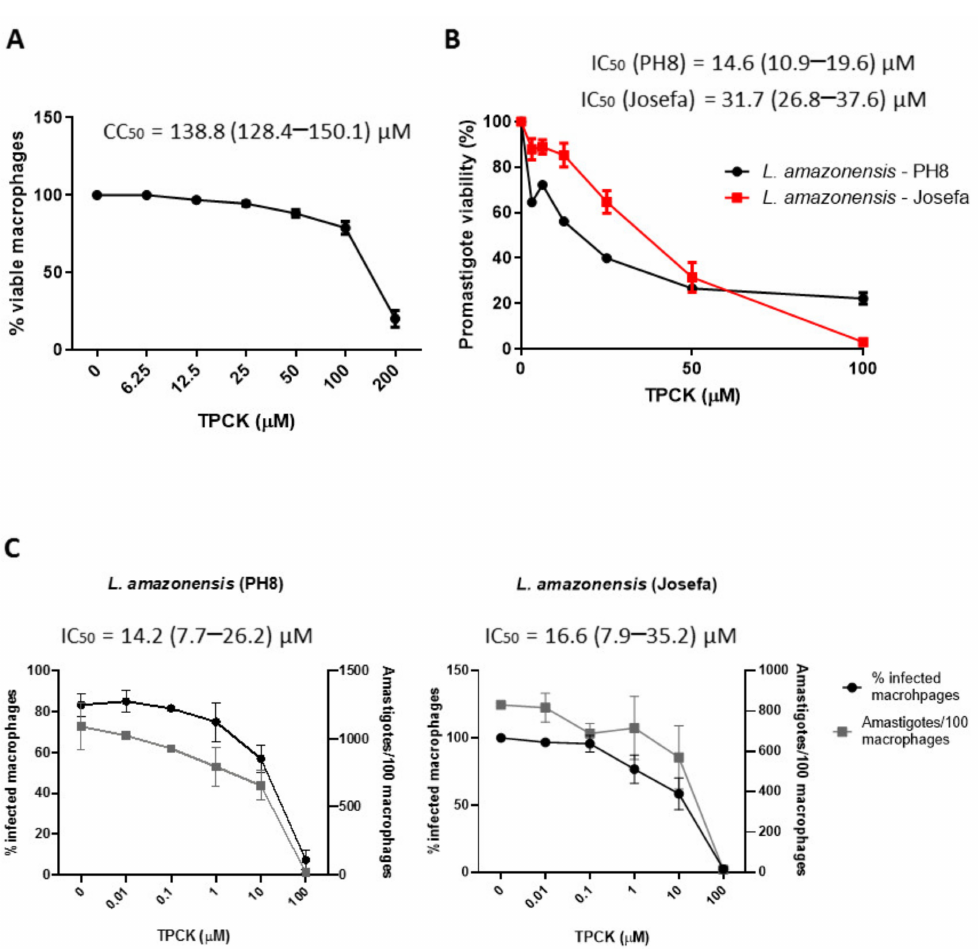
Figure 2. In vitro TPCK effects against peritoneal macrophages and L. amazonensis . ( A ) Cytotox- icity of TPCK against peritoneal macrophages from BALB/c mice. These cells were distributed in 96-well plates, incubated with TPCK at 37 ◦ C under a 5% CO 2 atmosphere for 72 h, and cell viability was determined by the MTT assay. ( B ) Inhibitory TPCK effect in L. amazonensis promastigotes (black line—PH8 strain, red line—Josefa strain). Promastigotes were distributed in 96-well plates, incubated with TPCK at 26 ◦ C for 72 h, and cell viability was determined by the MTT assay. ( C ) Inhibitory TPCK effect in intracellular L. amazonensis amastigotes (PH8 and Josefa strains). These forms were treated with different TPCK concentrations for 72 h and subsequently counted. Graphs were plot- ted using GraphPad Prism 8 (GraphPad Software, Inc., La Jolla, CA, USA). Results are expressed as means ± standard error. IC 50 and CC 50 values were obtained by non-linear regressions using Graphpad Prism 8 software. Graphs are representative of three independent